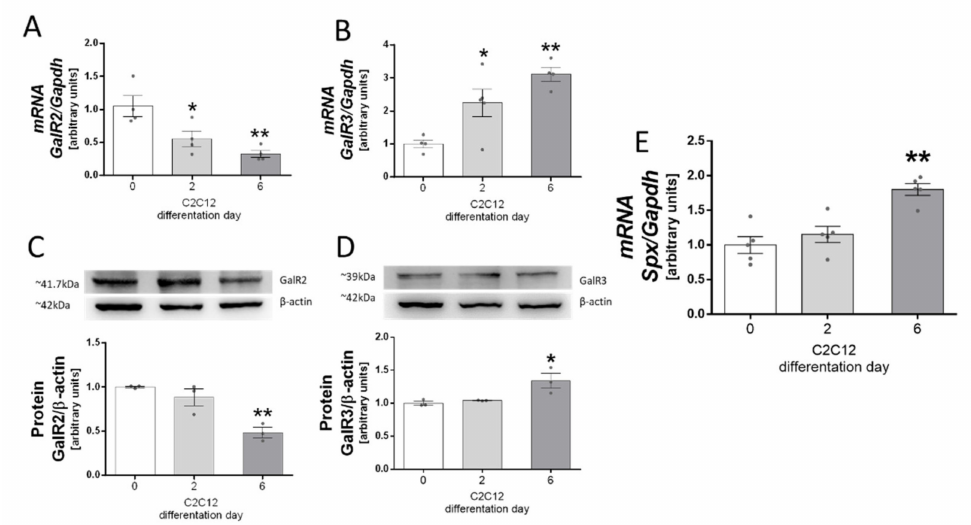
Figure 1. GalR2 and GalR3 mRNA ( A , B ) and protein ( C , D ) expression changes during the C2C12 differentiation process. SPX mRNA ( E ) levels in undifferentiated and differentiated cells. Values are presented as mean ± standard error of the mean (S.E.M.). Statistically significant differences are marked for p < 0.05 (*) and p < 0.01 (**) compared to day 0. The experiments were performed using n = 2 per investigated day. All experiments were